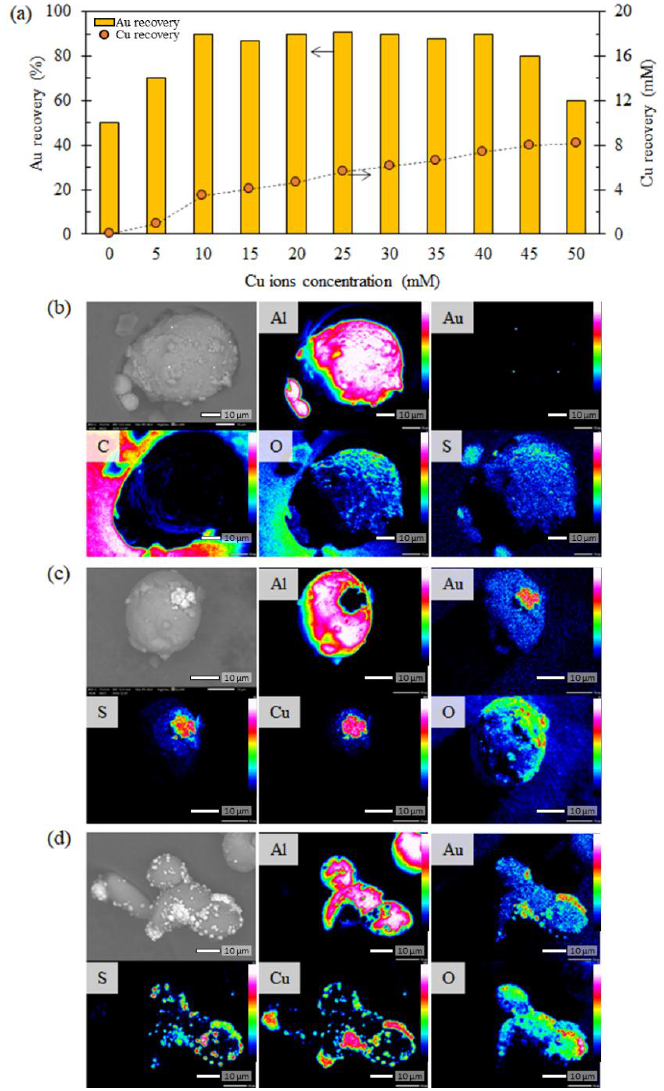
Figure 2. ( a ) Recovery of gold ions from ammonium thiosulfate solution with varying additions of Cu ions with concentrations from 0 to 50 mM, and SEM photomicrographs with corresponding elemental maps of the residues at ( b ) 0 mM, ( c ) 10 mM, and ( d ) 50 mM of Cu ion additions.